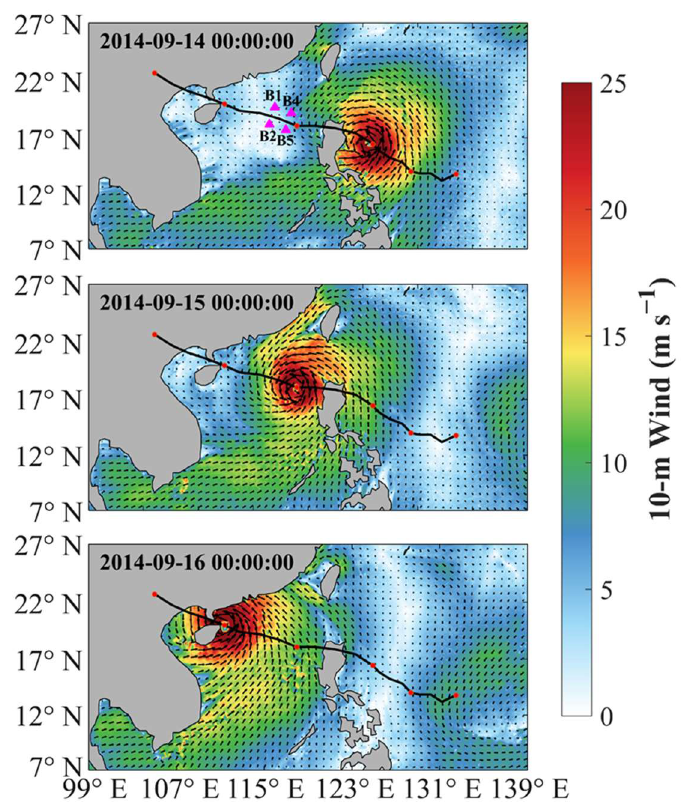
Figure 6. Spatial distribution of daily mean 10-m wind (m s −1 ) from WRS coupled experiment. Vectors are wind direction and the background color represents wind magnitude. Top to bottom: 00:00 14 September, 00:00 15 September and 00:00 16 September. The black line shows the TC track and the red dots are the TC positions between 12 to 17 September, with 1-day intervals, and the magenta triangles are the buoys’ locations.